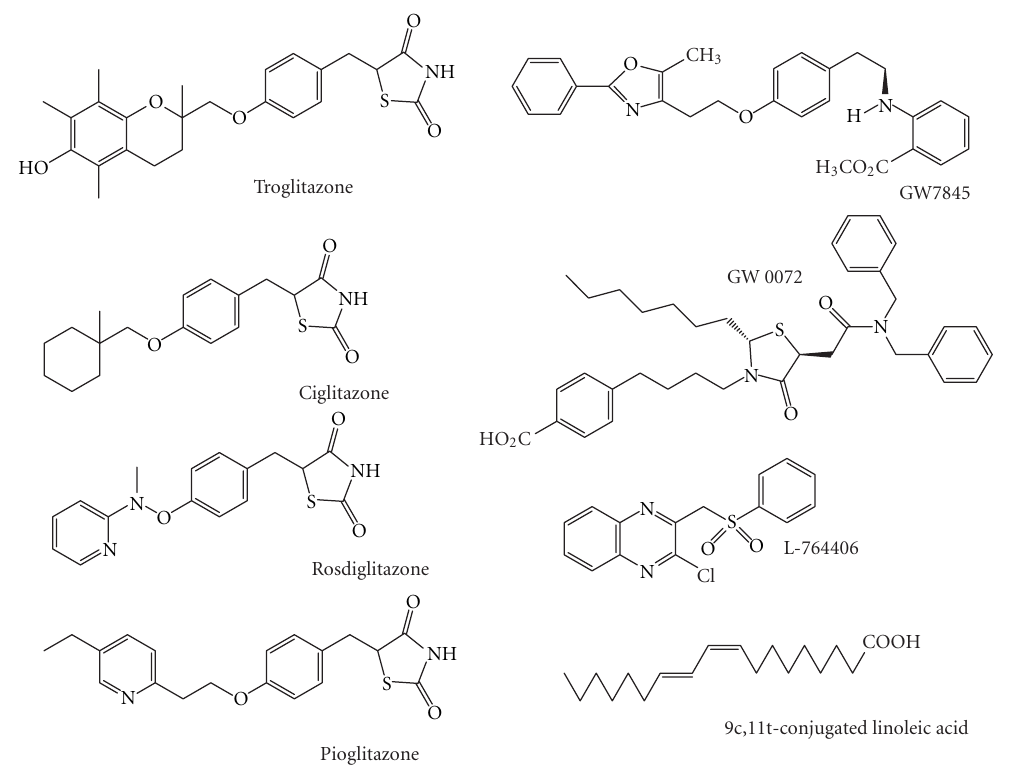
Figure 2: Synthetic and naturally occurring ligands for PPAR γ